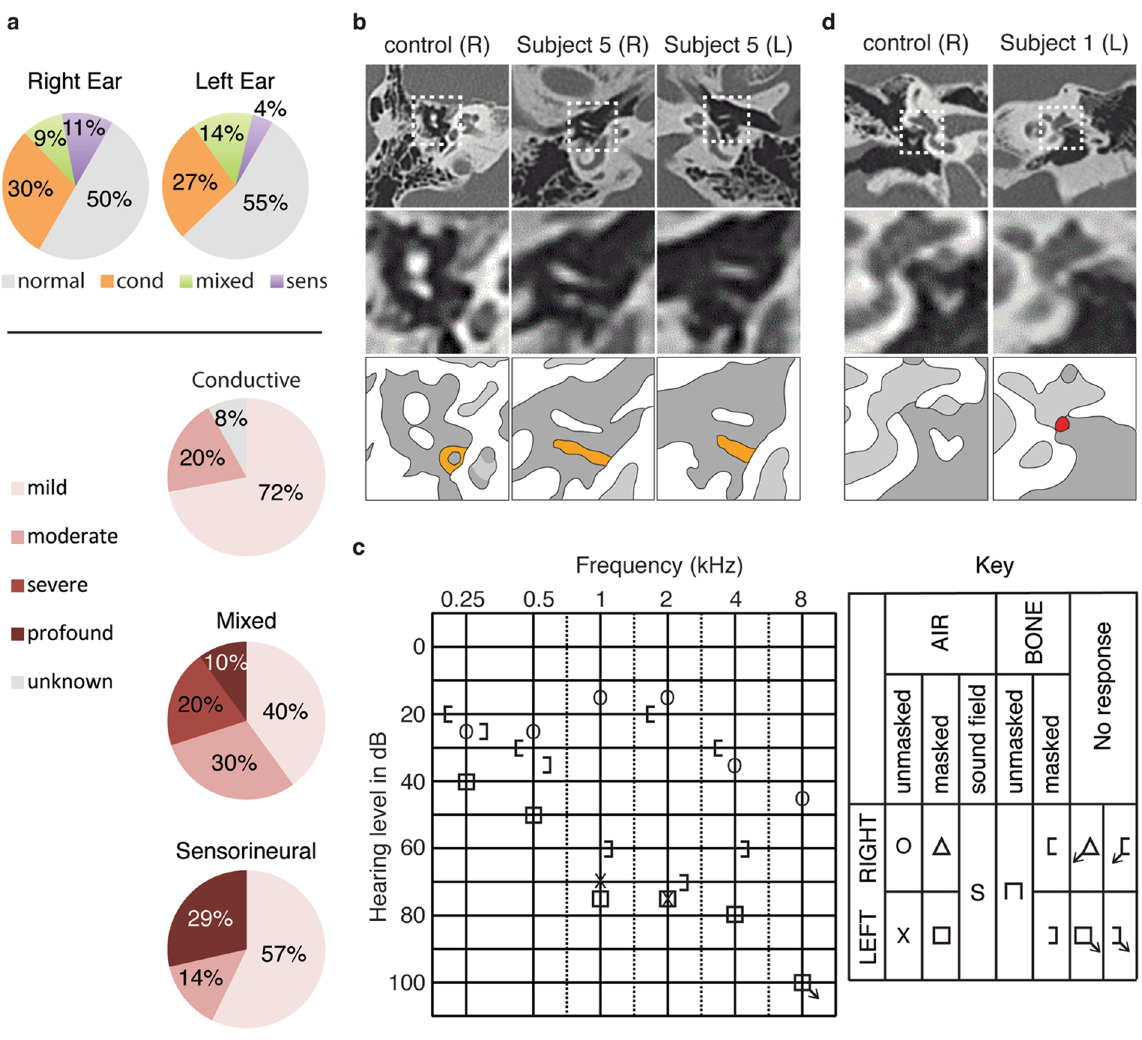
Figure 5. Hearing loss and middle ear defects in patients heterozygous for JAG1 mutations and/or diagnosed with AGS. ( a ) The ratio of types of hearing loss for the right and left ears were calculated based on the 44 subjects tested. The degrees of hearing loss encompassed in each type of hearing loss were also analyzed. Table S1 lists the degrees of hearing loss as a range indicating the loss at its best frequency and worst frequency. The categorical analyses illustrated by the pie charts have taken into account only the loss at the worst frequency. ( b ) CT scans of the temporal bone in the axial plane from a control 69-year-old male without AGS and subject 5 who is heterozygous for a JAG1 loss-of-function mutation. Magnified areas of the dashed box regions and accompanying diagrams are shown below. Compared to the right stapes (orange) from the control subject, the right and left stapes of subject 5 appear as a single rod (i.e. columellar). Adjacent sections showed relatively normal articulation of the stapes with the incus. For better comparison, the orientation of the left stapes is flipped horizontally in the magnified view. ( c ) Audiogram of subject 5 (see Table 2) indicates mild to profound mixed hearing loss in the left ear and normal to mild sensorineural hearing loss with a potential high-frequency conductive component in the right ear. ( d ) Compared to a control 69-year-old male without AGS, CT scans of the temporal bone in the coronal plane show inappropriate ossification (red) of the oval window in the left ear of subject 1. The control right ear is flipped horizontally in the magnified area and accompanying